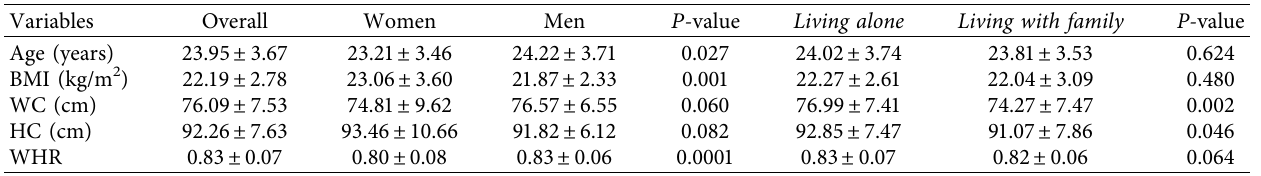
Table 4: Anthropometric characteristics of the study population.